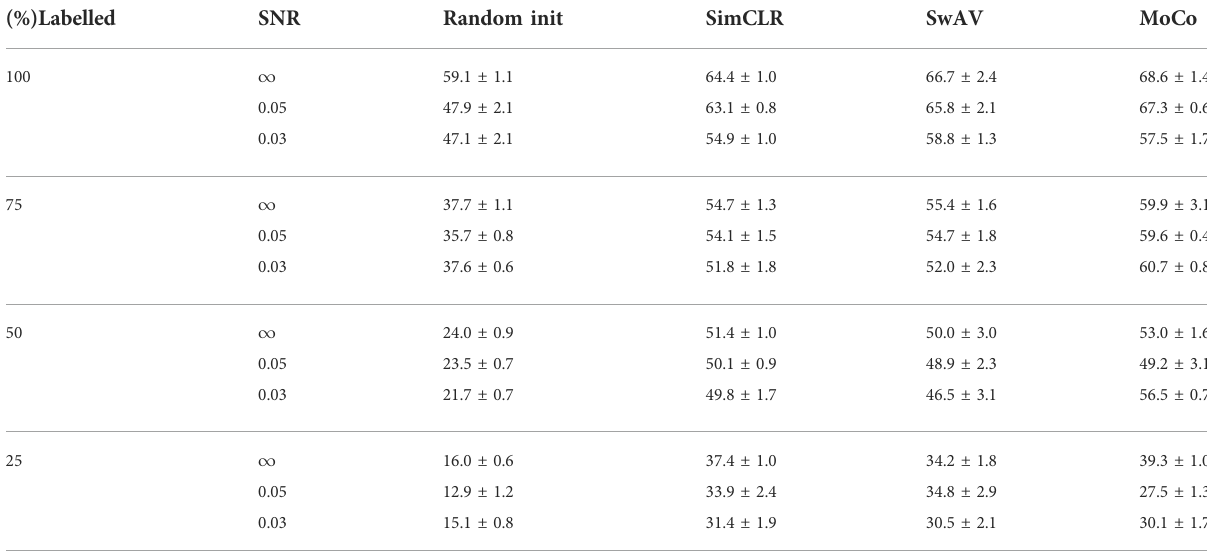
TABLE 1 Comparison of subtomogram classi fi cation accuracy (%) with standard deviation on experimental biological data. Classi fi er with CSSL pretrained initial weights performs much better than classi fi er with random initial weights. (%)Labelled